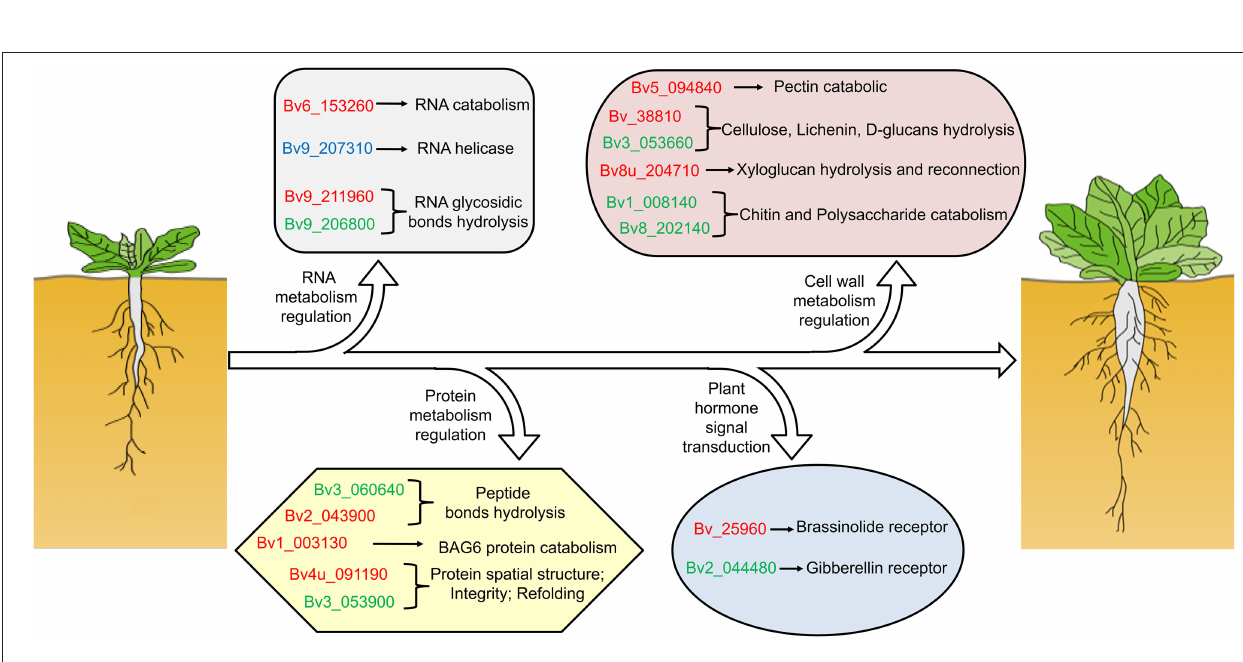
Frontiers in Plant Science |